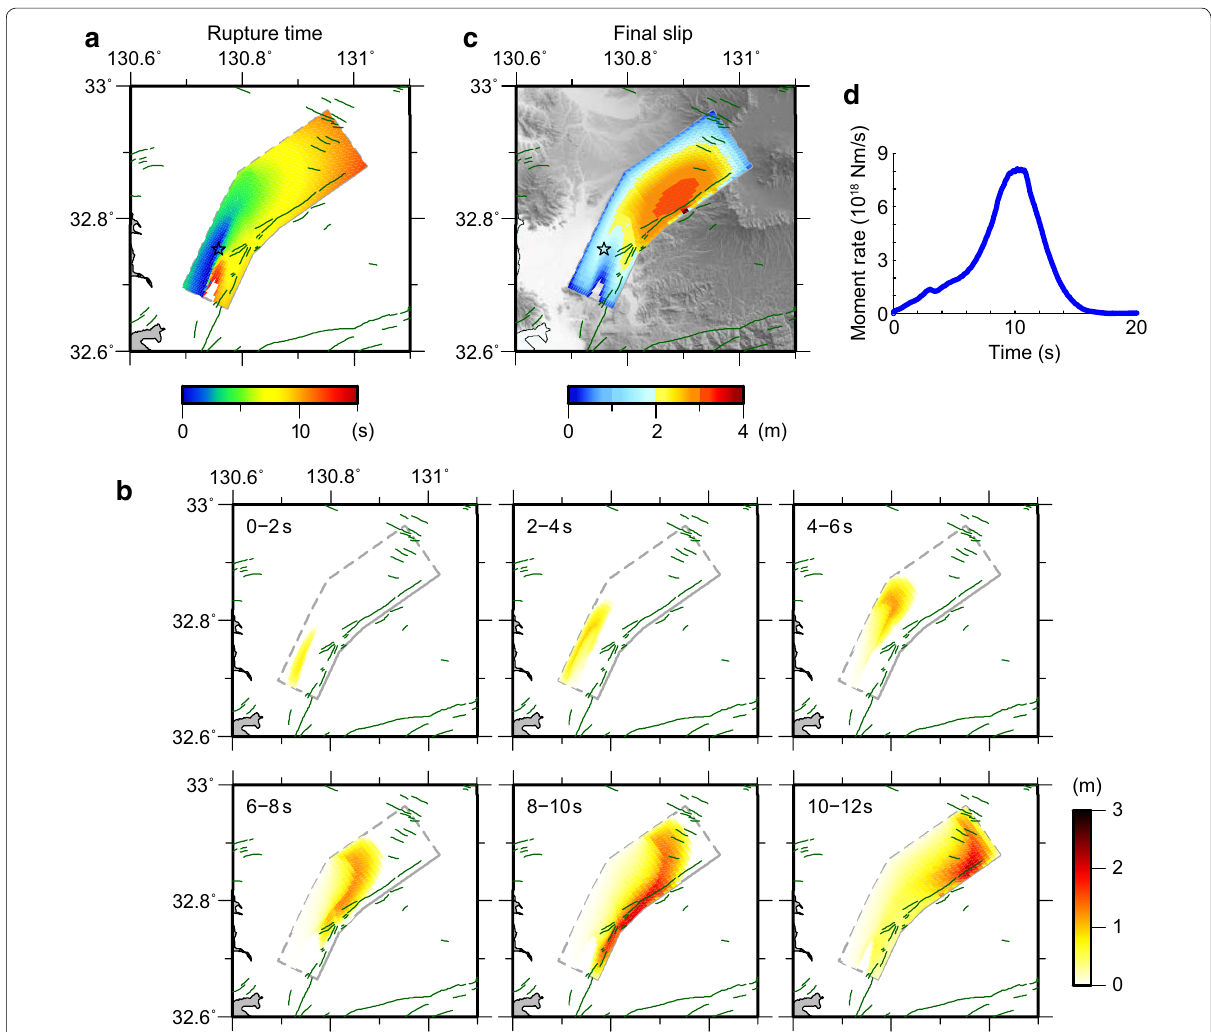
Fig. 9 a Rupture time, b slip amount for each 2-s time window, c final slip distribution, and d moment rate function in case A2 with the free sur- face. Note that the color scale in c is different from that in right panels of Fig.